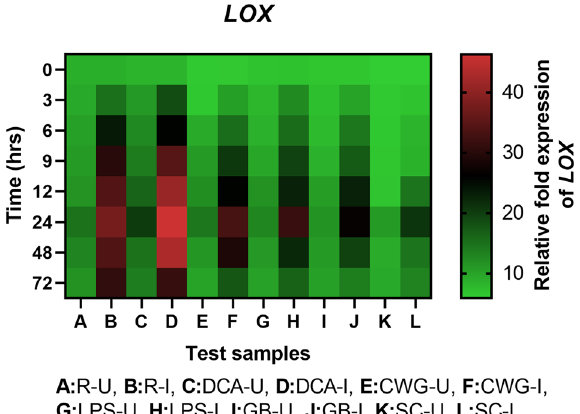
Figure 11. qRT-PCR determined relative expression of LOX genes in 2-day-old P. glaucum seedlings with (I) or without (U) Sclerospora graminicola inoculation harvested 0, 3, 6, 9, 12, 24, 48, and 72 h. R—resistant, S— susceptible, DCA—3,5-Dichloroanthranilic acid treated, CWG—Cell Wall Glucans isolated from the endophyte Trichoderma hamatum UOM 13, LPS—Lipopolysaccharides isolated from bacteria Pseudomonas fluorescens UOM 14, GB—Glycinebetaine an amino acid derivative. Expression levels were measured by qPCR and normalized to the constitutive PP2A gene. Values are means of experiments carried out in four replicates. The bars indicate ± SE and the data were analyzed by one-way ANOVA followed by Tukey’s test and p ≤ 0.05.